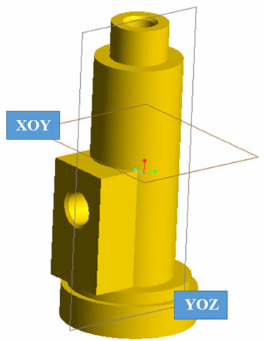
Figure 7. Position of the motor cutting